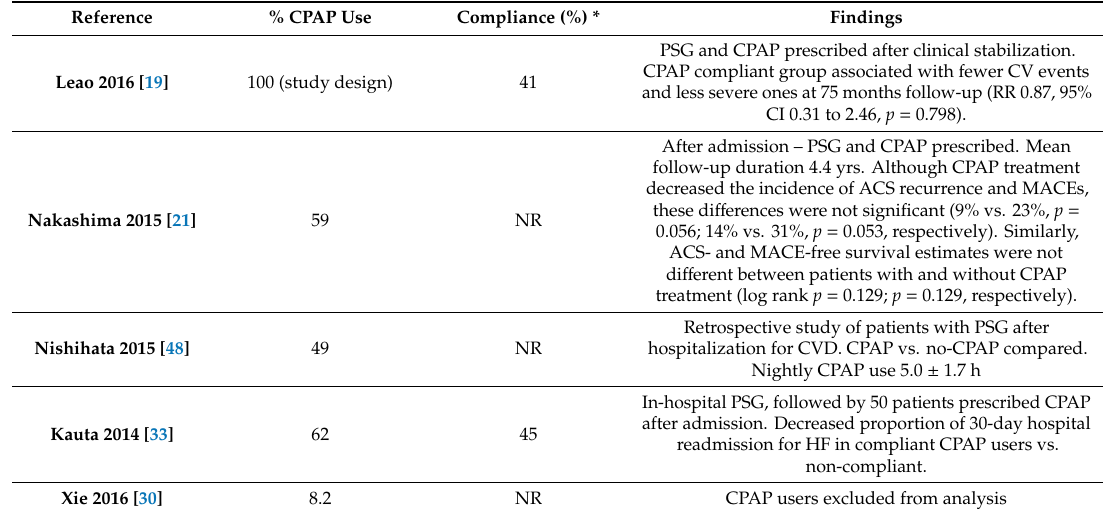
Table 3. Proportion of patients receiving positive airway pressure therapy for